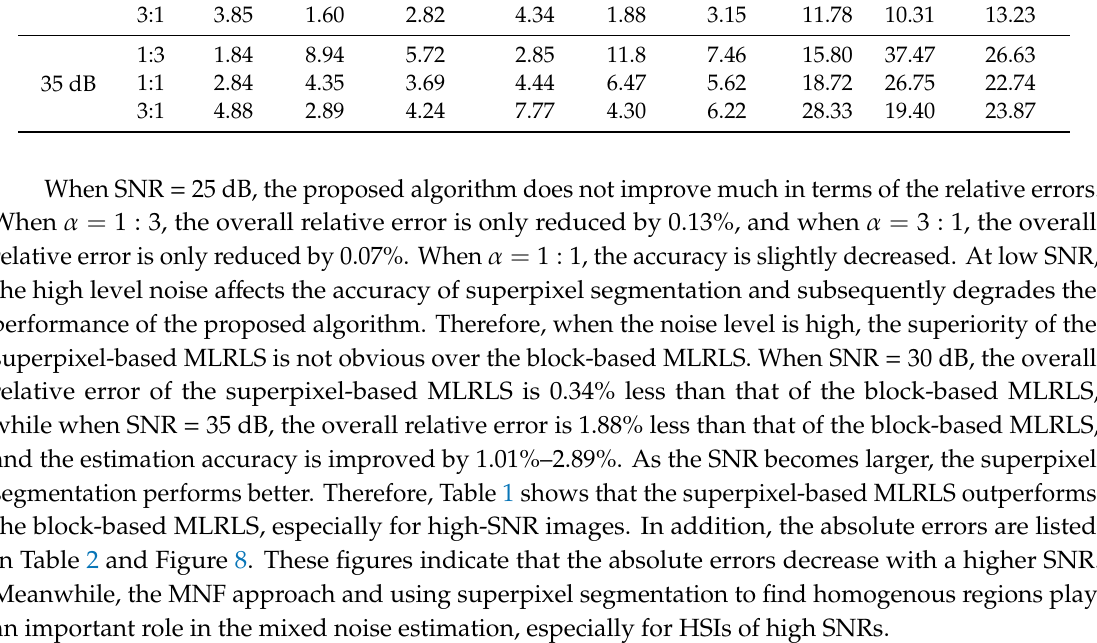
superpixel-based MLRLS.